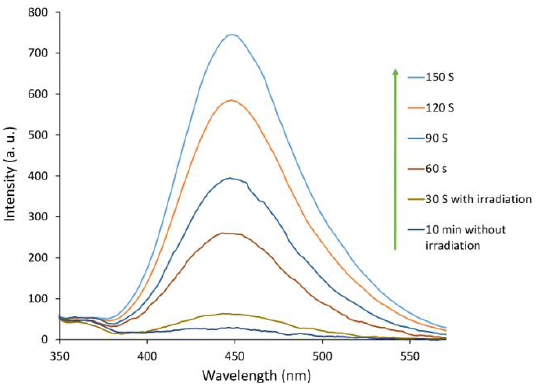
Figure 8. The temporal changes in the fluorescence intensity of 2-hydroxyl-terephthalic acid upon irradiation with UV light (290 nm) in the presence of S 4 .